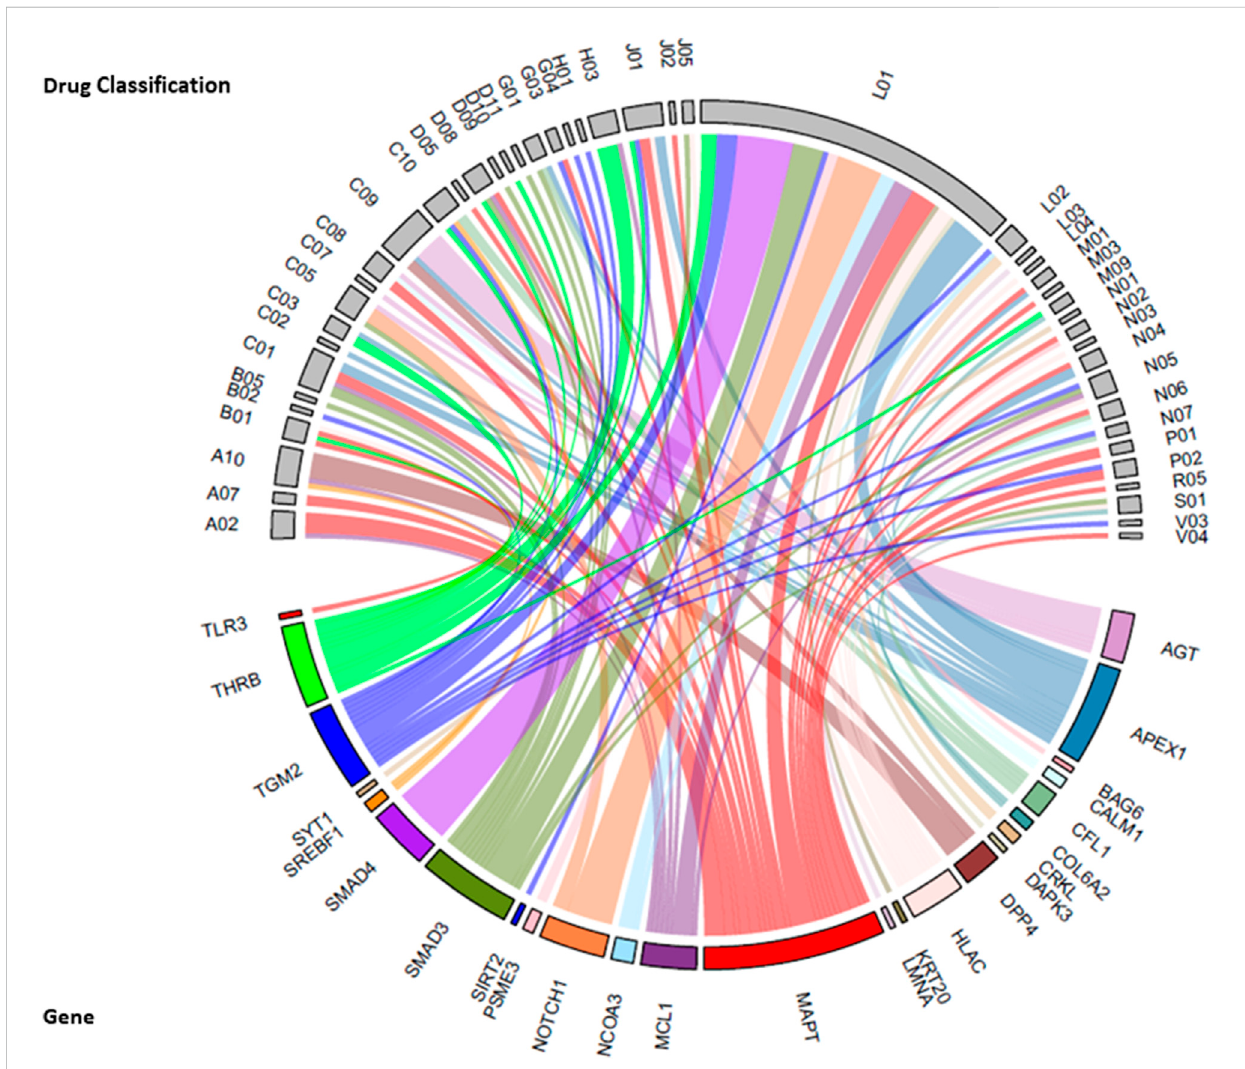
FIGURE 5 Chord diagram of sub-network genes associated with the common factor and the drug-gene interactions with the second level Anatomical Therapeutic Chemical (ATC)classi fi cation(therapeutic subgroup)ofdrugs. Thewidthofeachline representsthenumberofdrugs knowntointeractwith each gene. Therapeutic subgroup ATC Drug classi fi cations: A02 = Drugs for acid-related disorders, A07 = antidiarrheals, intestinal anti-in fl ammatory/ anti-infective agents, A10 = drugs used in diabetes, B01 = antithrombotic agents, B02 = antihemorrhagics, B05 = blood substitutes and perfusion solutions, C01 = cardiac therapy, C02 = antihypertensives, C03 = diuretics, C05 = vasoprotectives, C07 = beta blocker agents, C08 = calcium channel blockers,C09=agentsactingonrenin-angiotensinsystem,C10=lipidmodifyingagents,D05=antipsoriatics,D08=antisepticsanddisinfectants,D09= medicated dressing, D10 = anti-acne preparations, D11 = other dermatological preparations, G01 = gynecological anti-infective and antiseptics, G03 = sex-hormones and modulators of the genital system, G04 = urological, H01 = pituitary and hypothalamic hormones and analogues, H03 = thyroid therapy, J01 = antibacterial for systemic use, J02 = antimycotics for systemic use, J05 = antivirals for systemic use, L01 = antineoplastic agent, L02 = endocrine therapy, L03 = immunostimulants, L04 = immunosuppressants, M01 = anti-in fl ammatory and antirheumatic products, M03 = muscle relaxants, M09 = other drugs for disorders of the Musculo-skeletal system, N01 = anesthetics, N02 = analgesics, N03 = antiepileptics, N04 = anti- Parkinson drugs, N05 = psycholeptics, N06 = psychoanaleptics, N07 = other nervous system drugs, P01 = antiprotozoals, P02 = anthelmintics, R05 = cough and cold preparations, S01 = opthalmologicals, V03 = all other therapeutic products, V04 = therapeutics